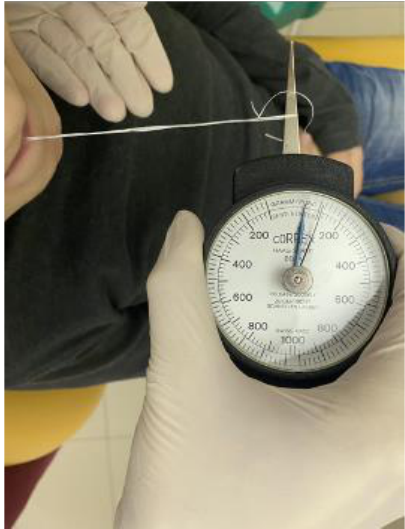
Figure 3. Strength measurement of the orbicularis muscle. A dynamometer was used in a standardized way: the length of the thread was 40 cm; the thread was folded in half, with a button on one end, and a knot on the other.